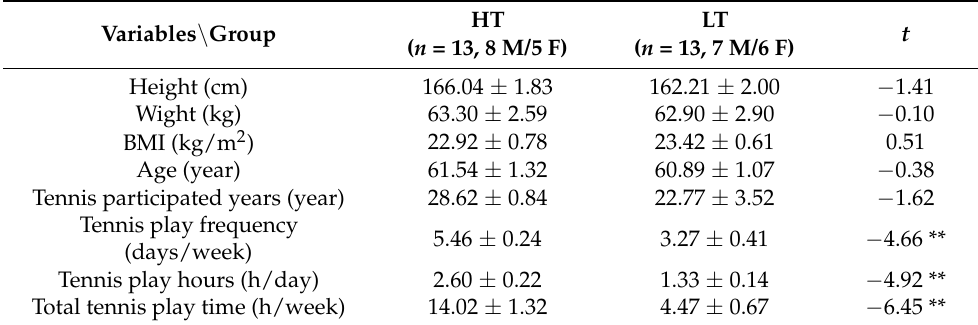
Table 1. Physical characteristics of